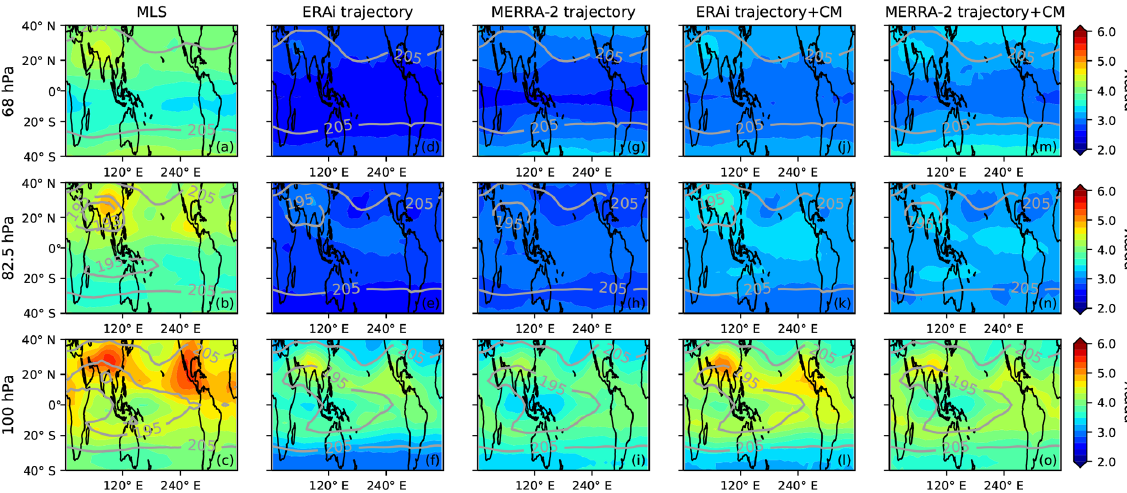
Figure 2. JJA water vapor (ppmv, color shading) and temperature (K, contour lines) between 40 ◦ S and 40 ◦ N from the (a–c) MLS; (d– f) ERAi trajectory model; (g–i) MERRA-2 trajectory model; (j–l) ERAi trajectory model with the cloud model; and (m–o) MERRA-2 trajectory model with the cloud model at 68hPa (top row), 82.5hPa (middle row), and 100hPa (bottom